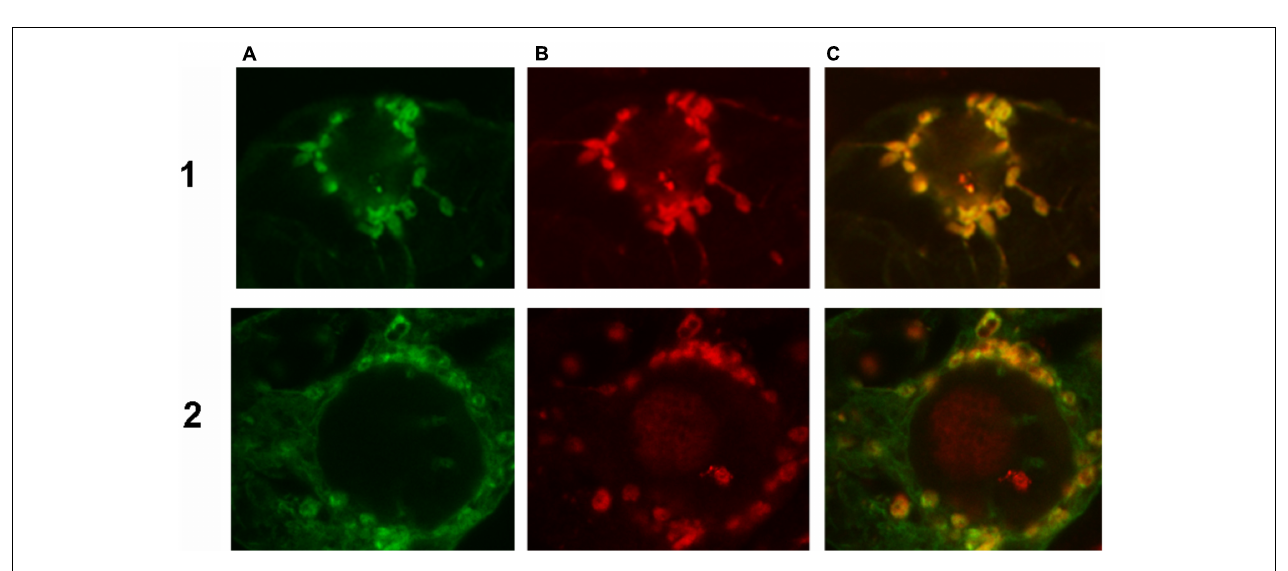
FIGURE 6 | Detail of the catalytic domain in the modeled Ha FatA enzyme. Catalytic amino acids are shown in red and amino acids conforming the hydrophobic pocket in green. The amino acids that altered activity when they were substituted by tryptophan (W) were labeled in blue (Moreno-Pérez et al., 2014). When there was a coincidence between the residues modified by mutagenesis and those described by Feng et al. (2017) they are indicated with an asterisk.